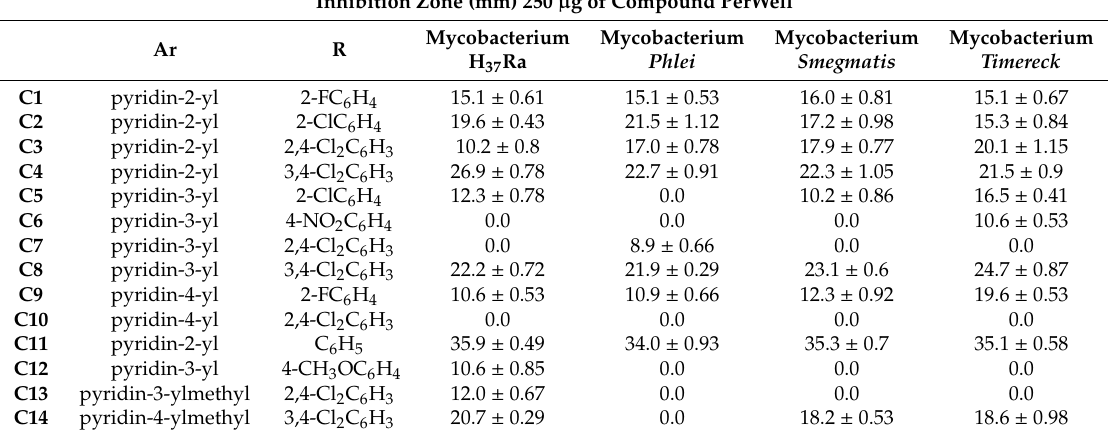
Table 3. Inhibition zone for tested compounds (250 µ g of the compound was used per well). The results were expressed as mean value ± standard deviation